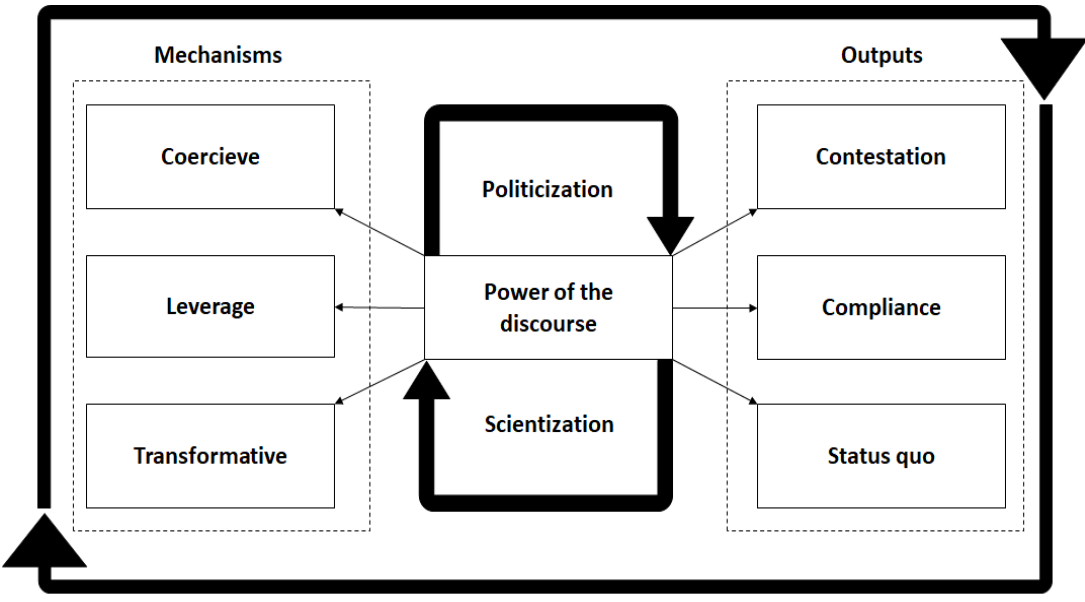
Figure 1. The power of the discourse over hydropower dams—key mechanisms and outputs.